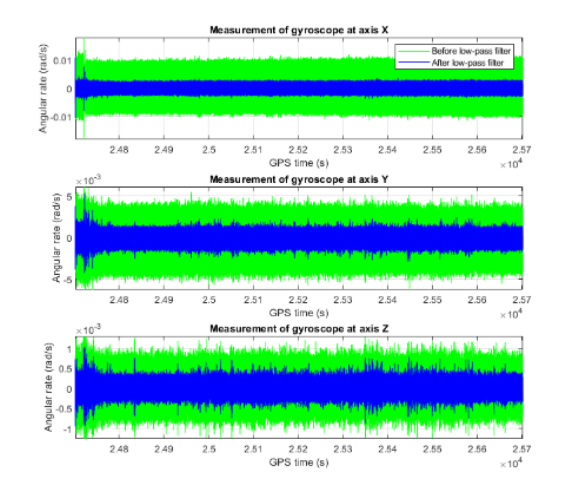
Figure 8 .Gyroscope measurements after the low-pass filter